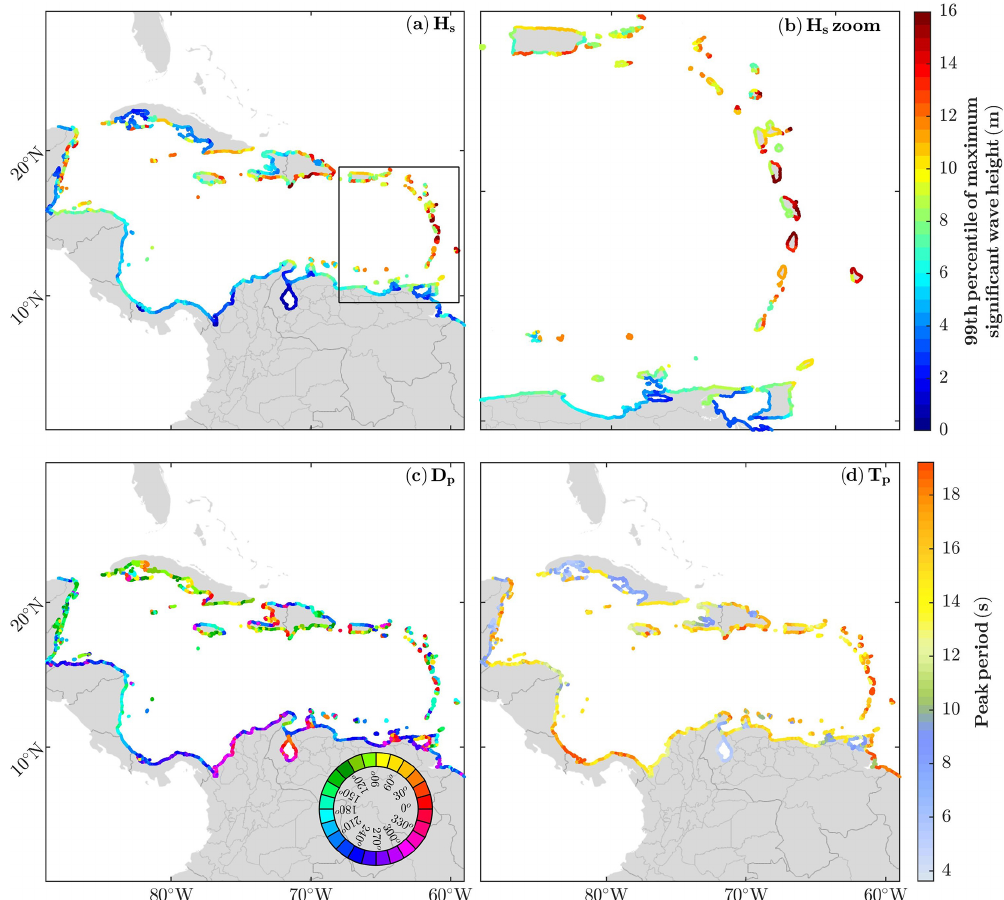
Figure 5. Fully coupled simulation results. Both (a) and (b) represent the 99th percentile of the maximum H s (that is, the value corresponding to the 10th most intense TC) for the whole domain (a) and a zoom on the Antilles area (b) . Panels (c) and (d) are the peak direction ( D p ), in nautical convention, and the median of peak period ( T p ) for waves over the 99th percentile, respectively. All panels were calculated using the nearest point to coast at a depth of 20m to avoid problems with relatively coarse shore